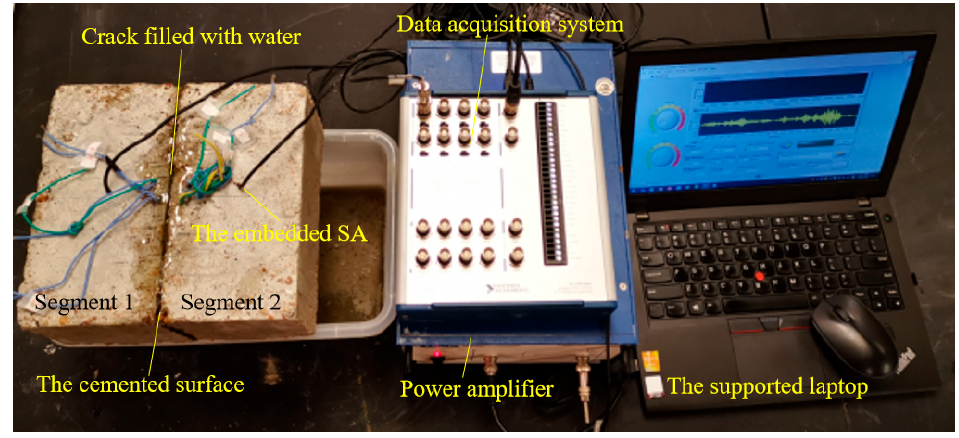
Figure 4. Experimental setup.